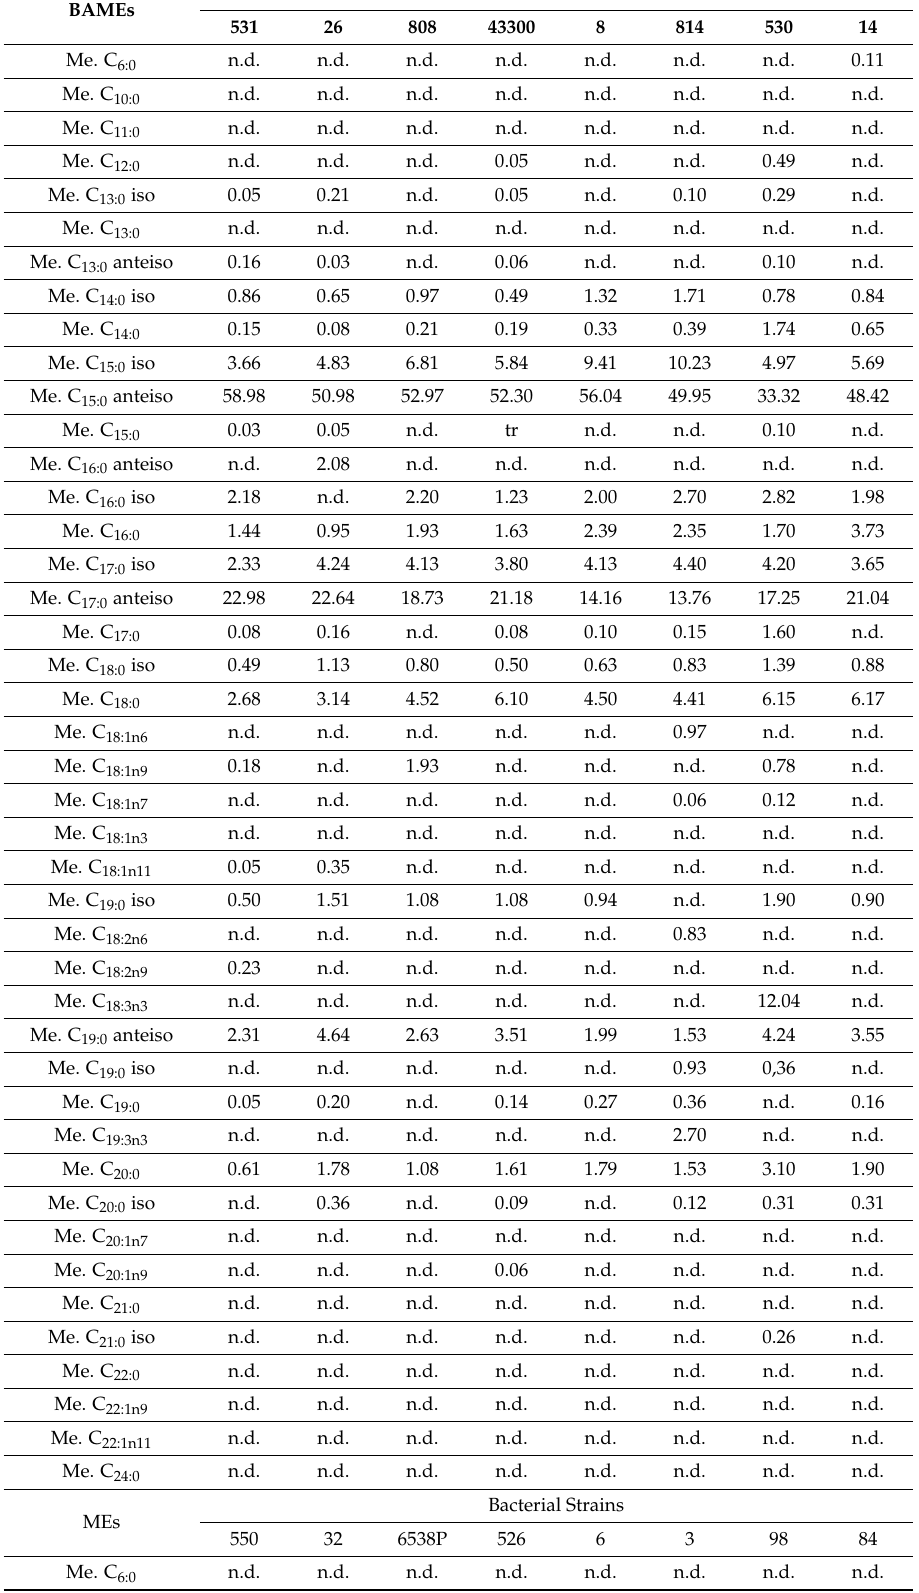
Table 1. Bacterial fatty acid methyl esters (BAMEs) quantified (%) in bacterial strains under study by Gas Chromatography-Flame Ionization Detector (GC-FID) analysis. n.d.= not detected; tr = traces.